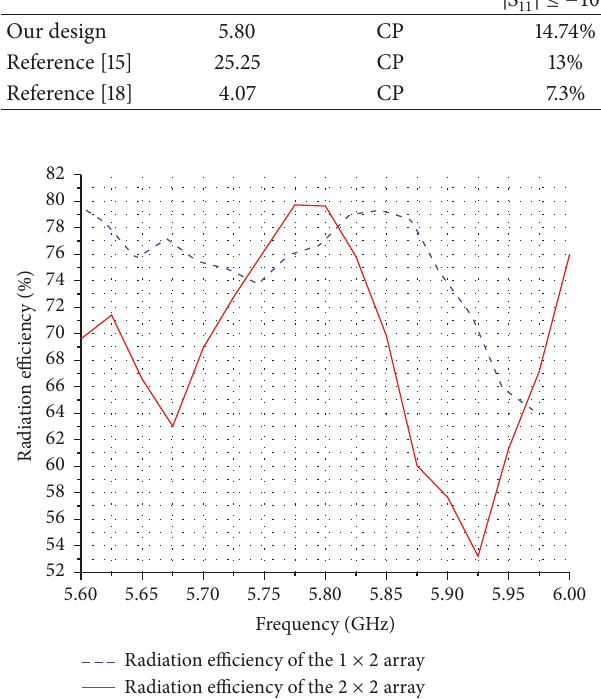
Figure 18: Measured radiation efficiencies of the 1 × 2 linear array and the 2 × 2